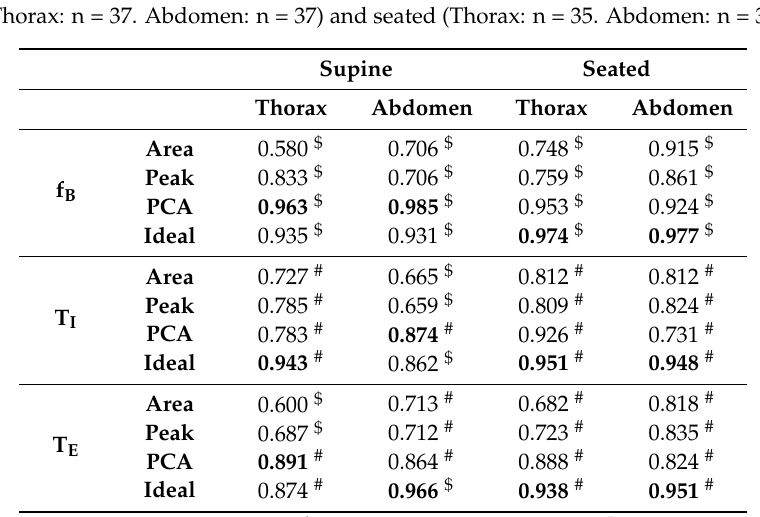
Correlations are all significant (p-value <0.001). $ Spearman correlation coefficient; # Pearson correlation coefficient; Bold: best correlation result.